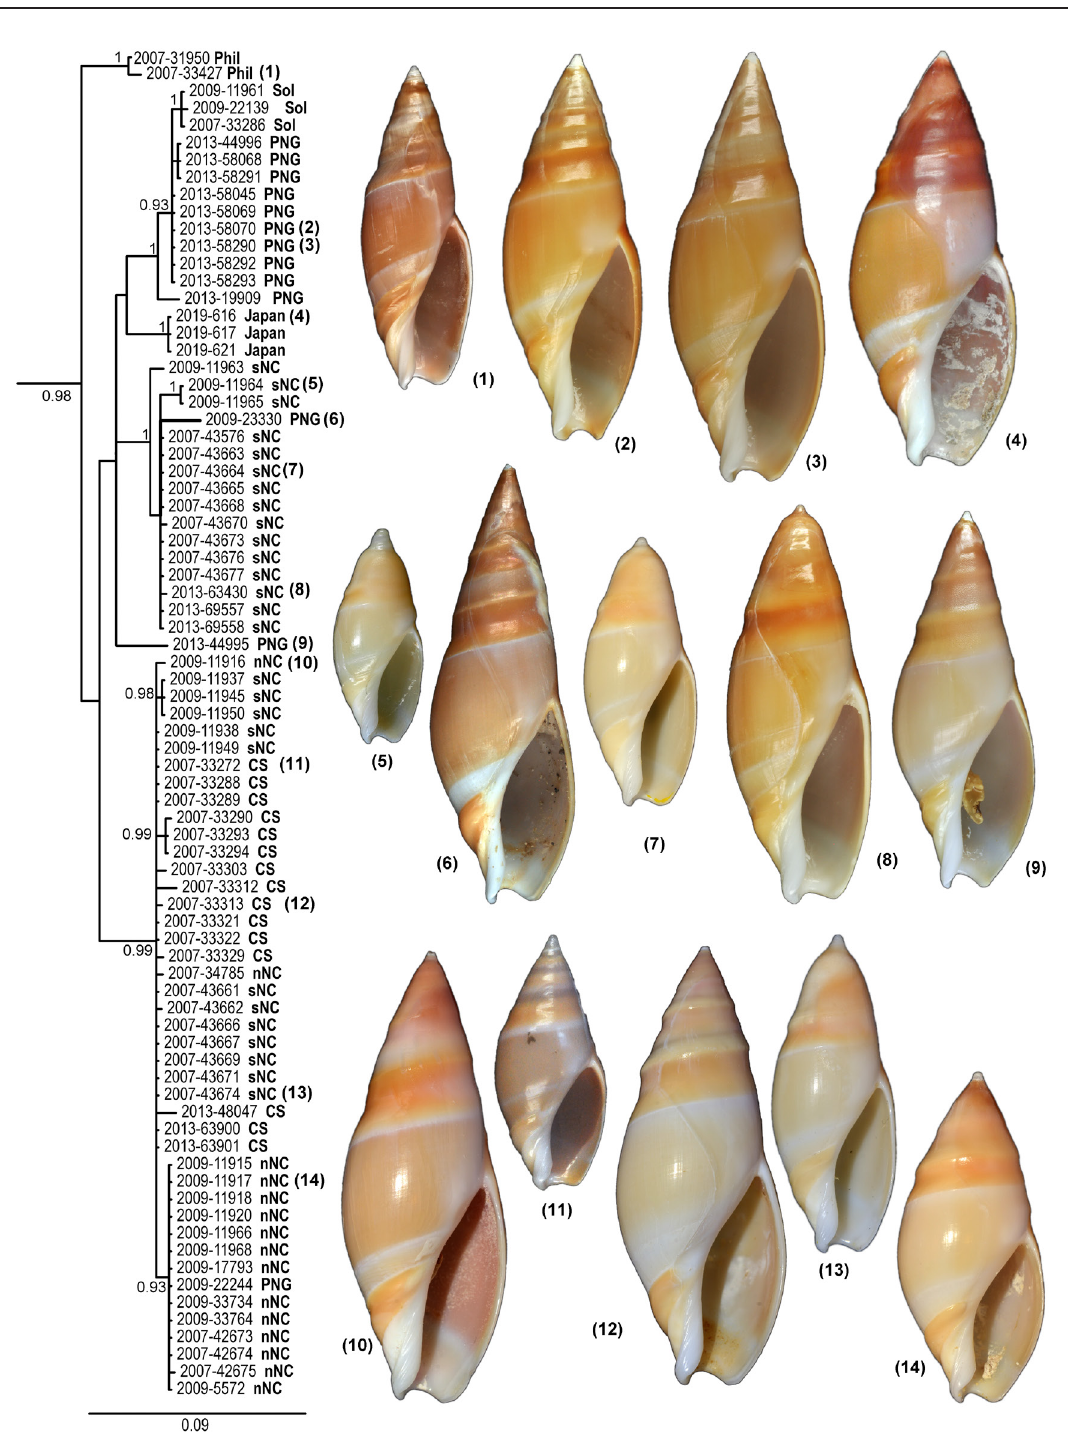
Fig. 2. Molecular phylogeny of Amalda hilgendorfi (von Martens, 1897) produced by a Bayesian analysis of the Cox1 gene dataset. Outgroups and other species of Amalda have been removed from the tree. Only posterior probabilities ≥ 90% are shown. The unit for the scale is “substitutions/site”. The geographical distribution and morphological morphs are coded for each specimen: Phil = Philippines; Sol = Solomon Islands; PNG = Papua New Guinea; sNC = South New Caledonia; nNC = North New Caledonia; CS = Coral Sea. Numbers in parentheses at the tips of the tree link the MNHN IM voucher number to the corresponding photo on